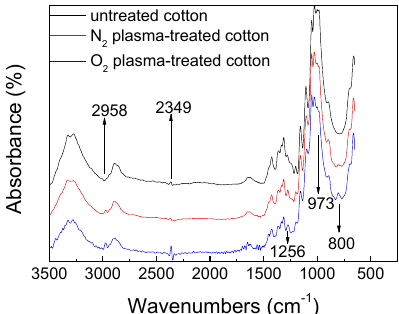
Figure 7. FTIR spectra of untreated cotton and plasma-treated cotton with N 2 and O 2 ionization gas.